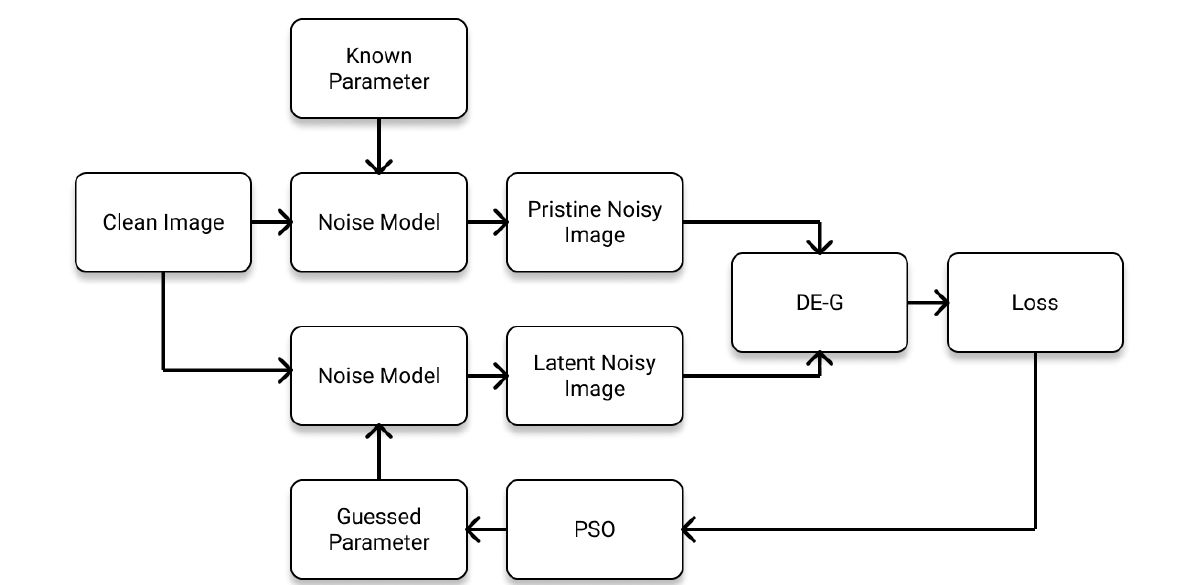
Figure 8. Block diagram for noise parameter estimation. The clean image is the ground truth image. To demonstrate the capability of DE-G in estimating accurate noise parameters, the clean image is injected with noise with a known set of parameters to produce the pristine noise image. The clean image is then injected with noise with a set of guessed parameters. The pristine noisy image and the latent noisy image are compared using DE-G. Through each iteration, the guessed parameters are updated using Particle Swarm Optimization (PSO). The algorithm ends after the maximum iteration number of PSO is